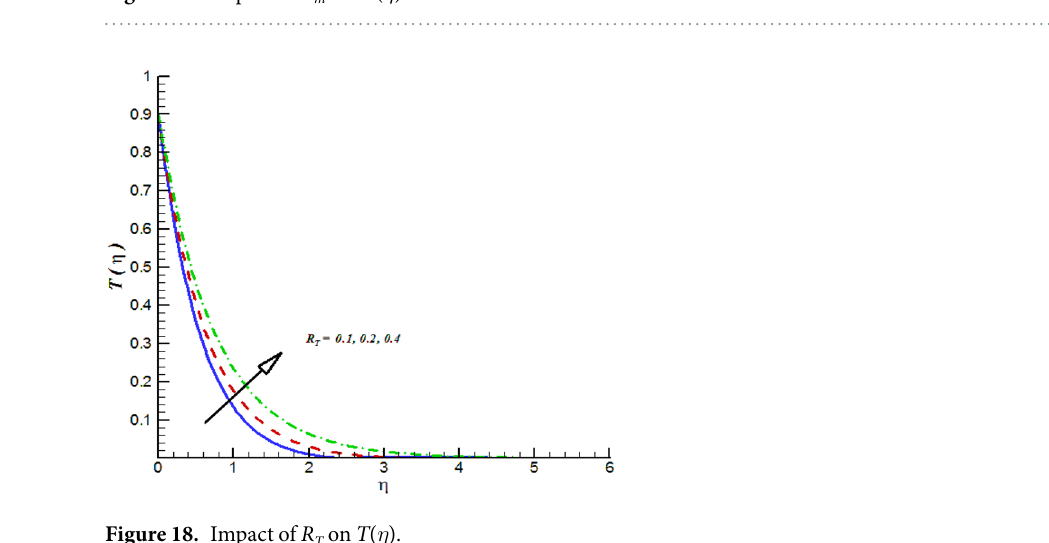
Figure 17. Impact of λ m on F ′ ( η ).